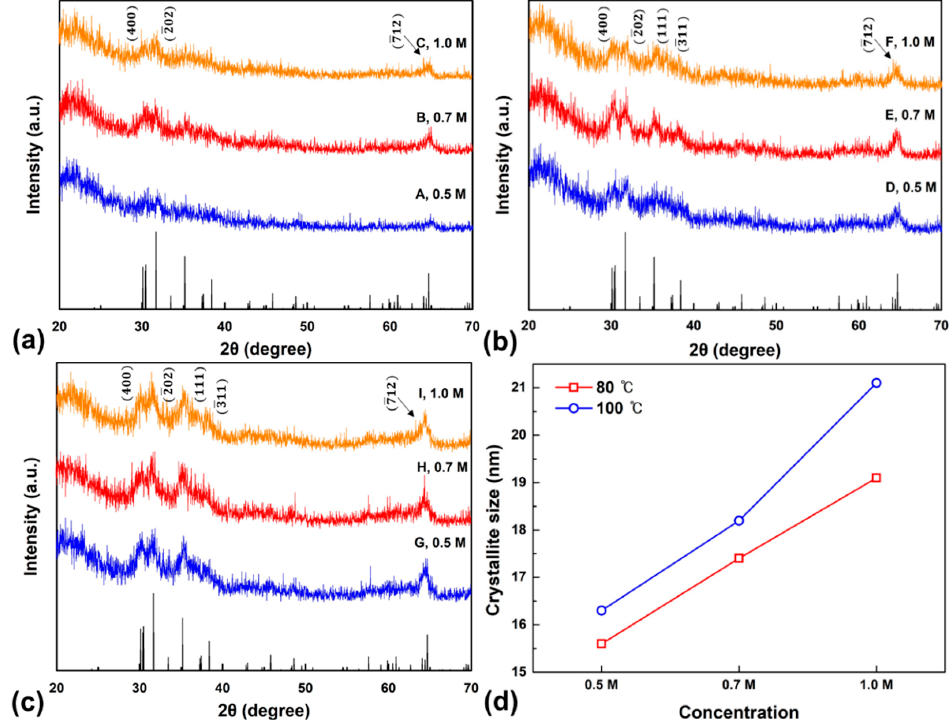
Figure 2. The XRD patterns of the β‐ Ga 2 O 3 films prepared at different drying temperatures: ( a ) 60 °C, ( b ) 80 °C, and ( c ) 100 °C. ( d ) Crystallite size of the β‐ Ga 2 O 3 thin films fabricated at drying temperatures of 80 and 100 °C.